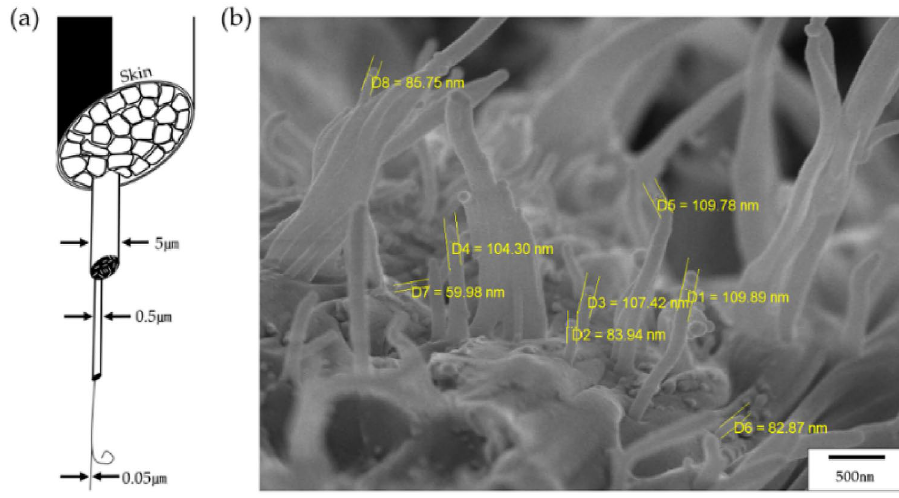
Figure 10. ( a ) Hierarchical structures in TLCP fibers 38 and ( b ) SEM micrograph of 230/9 fiber.